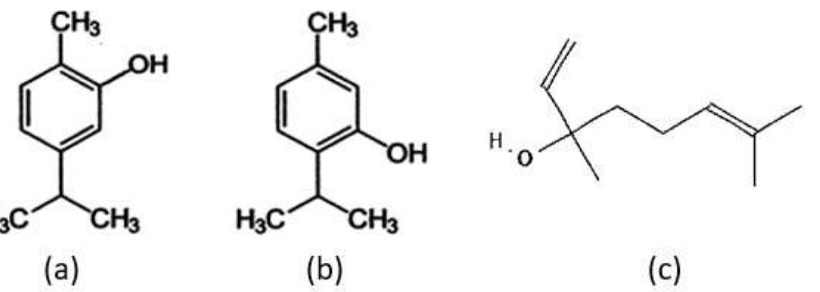
Figure 2. The chemical structure of thymol ( a ), carvacrol ( b ), and ( c ), linalool [16]. Linalool structure was retrieved from data deposited in or computed by PubChem (https://pubchem.ncbi.nlm.nih.gov, accessed on 1 January 2020).